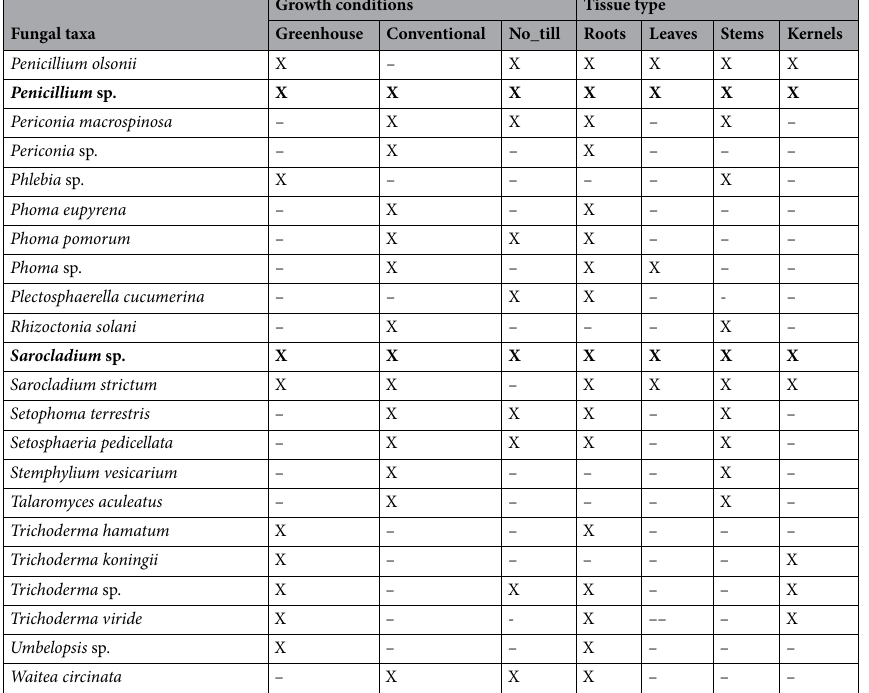
Table 1. Endogenous fungal taxa isolated from roots, leaves, stems and kernels of wheat cultivated in conventional field, no_till field and controlled greenhouse conditions.